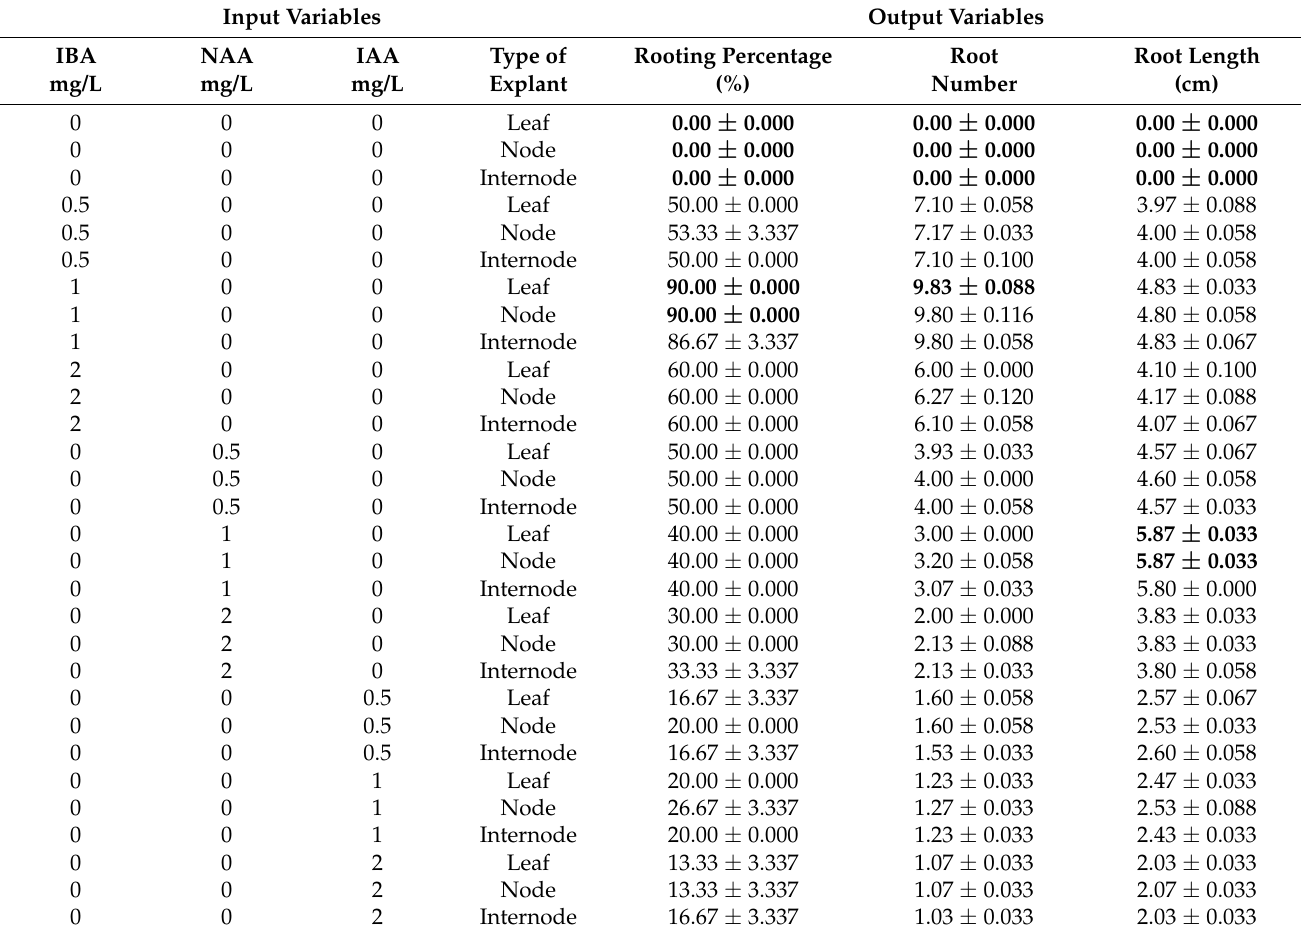
Table 1. Effect of type and concentration of auxins as well as type of explants on in vitro rooting of P. caerulea